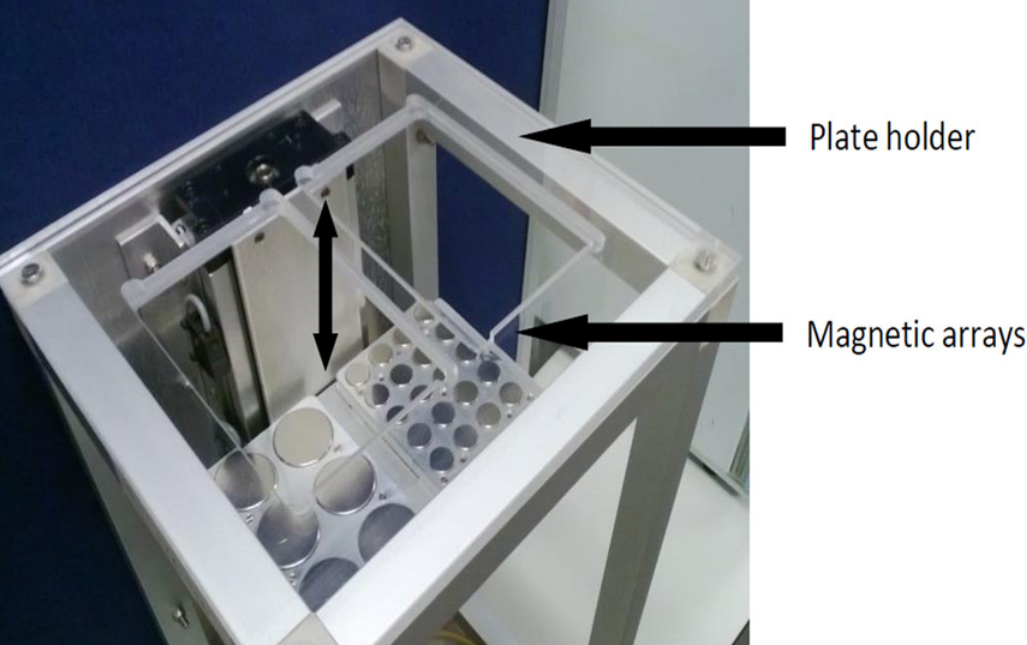
Fig 1. Magnetic Force Bioreactor. Image of the Magnetic Force Bioreactor used in magnetic stimulation experiments. Culture plates are situated on the plate holder above the magnetic array which oscillates vertically beneath the culture plates. The movement parameters for the array are computer controlled.